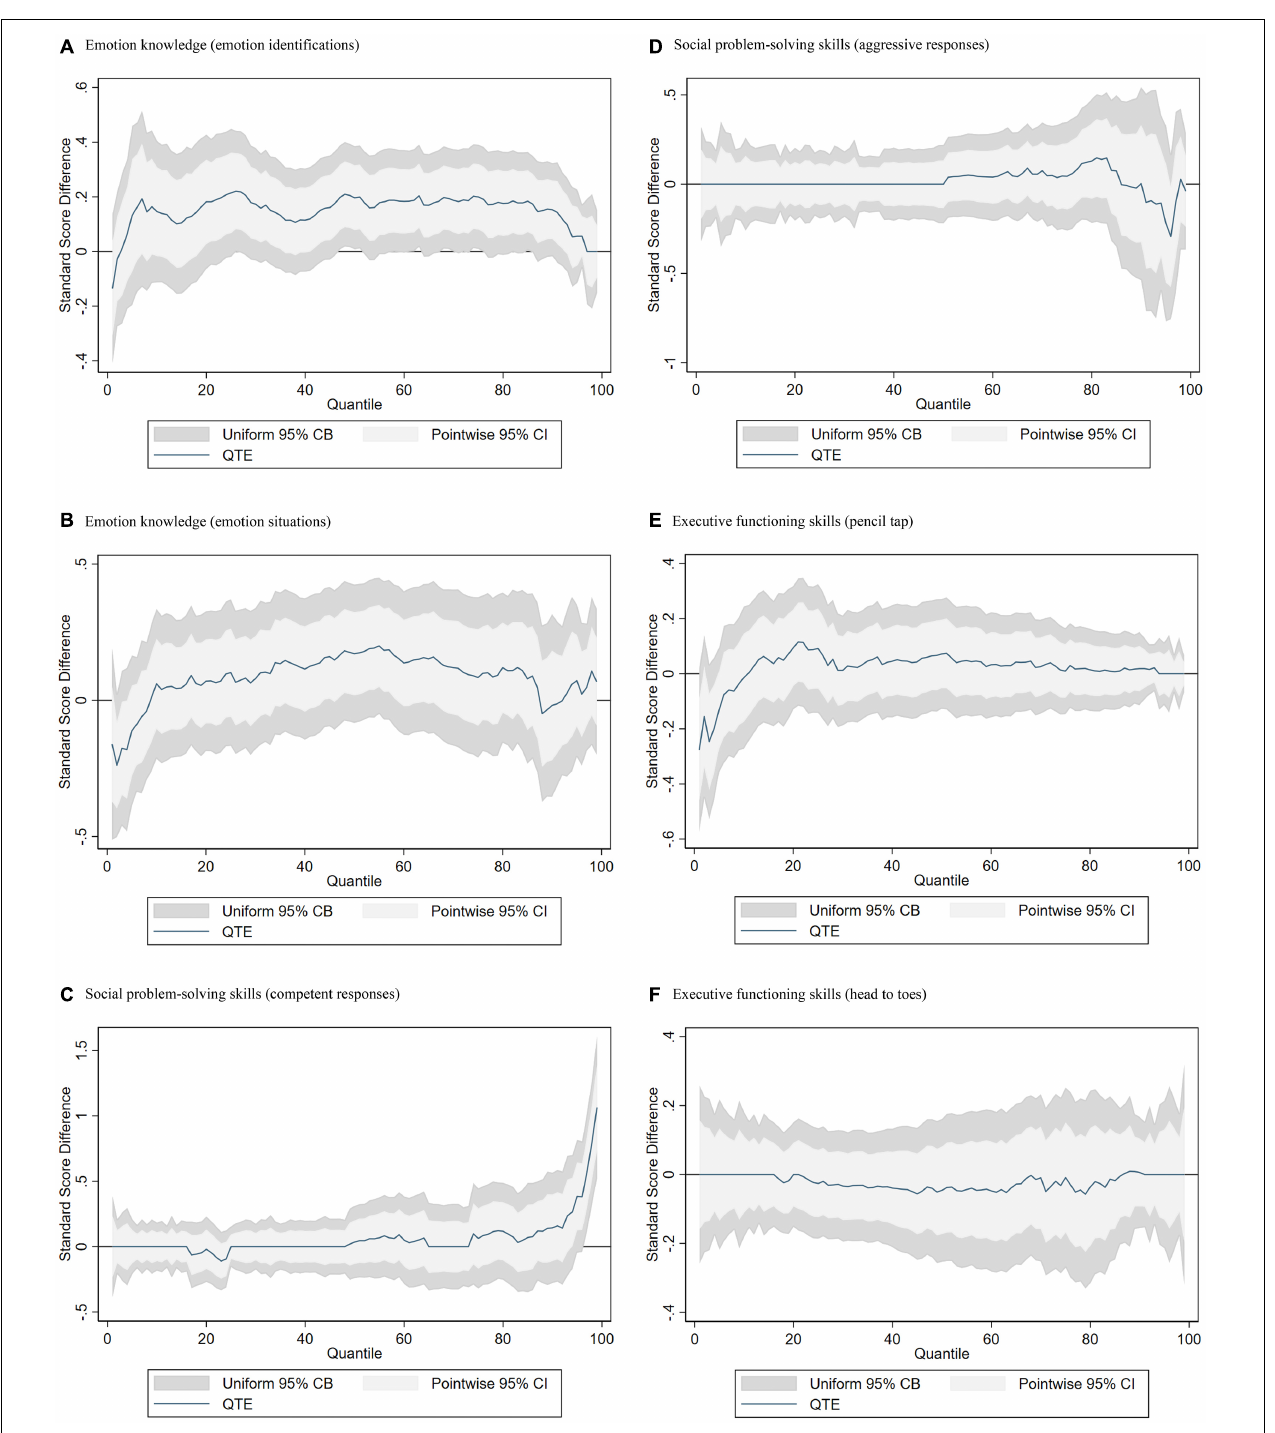
FIGURE 3 | Quantile treatment effect plots at the end of preschool. Inverse propensity-score weighted quantile treatment effect of assignment to socio-emotional curricula interventions on spring preschool outcomes, SE vs. non-SE. Each graph shows a student outcome QTE for the effect of being assigned to SE Head Start centers classroom. Estimates are weighted using inverse propensity-score weights. Weights are 1/ˆp for treatment observations and 1/(1-ˆp) for control observations, where ˆp is generated from a logistic regression of treatment status on baseline demographics, sample design variables, and baseline test scores. Ninety-five percent pointwise CIs and uniform CBs are shown. (A) Emotion knowledge (emotion identifications). (B) Emotion knowledge (emotion situations). (C) Social problem-solving skills (competent responses). (D) Social problem-solving skills (aggressive responses). (E) Executive functioning skills (pencil tap). (F) Executive functioning skills (head to